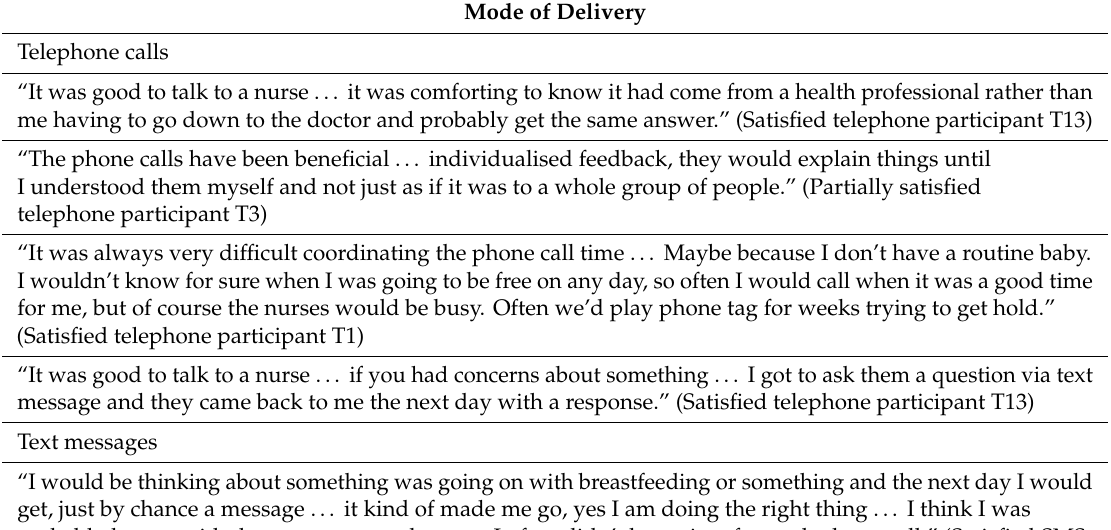
Table 6. Quotes related to participants’ perception of mode of